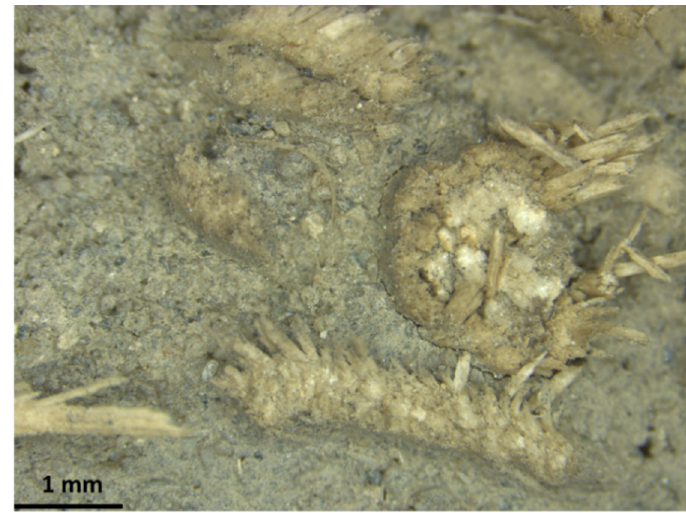
Figure 12. Microscopic image of hemp shiv inside the crude bricks.